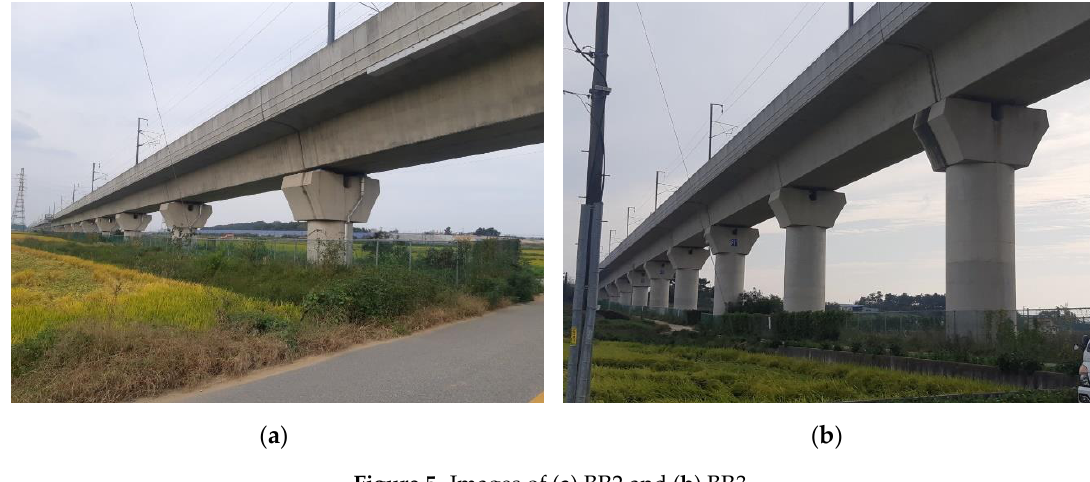
Figure 5. Images of ( a ) BR2 and ( b ) BR3.